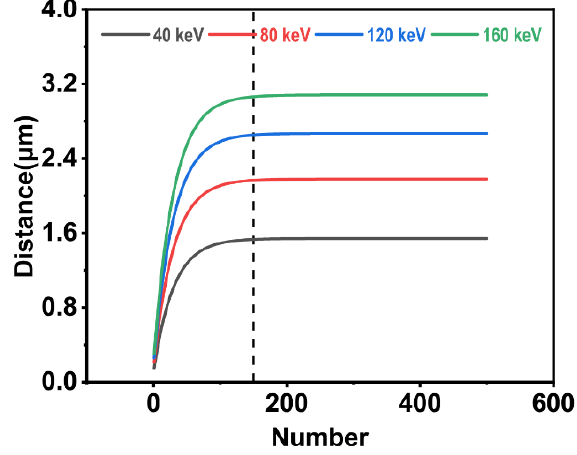
Figure 5. Relationship between the total penetration depth of a single carbon black particle and the total number of collisions.